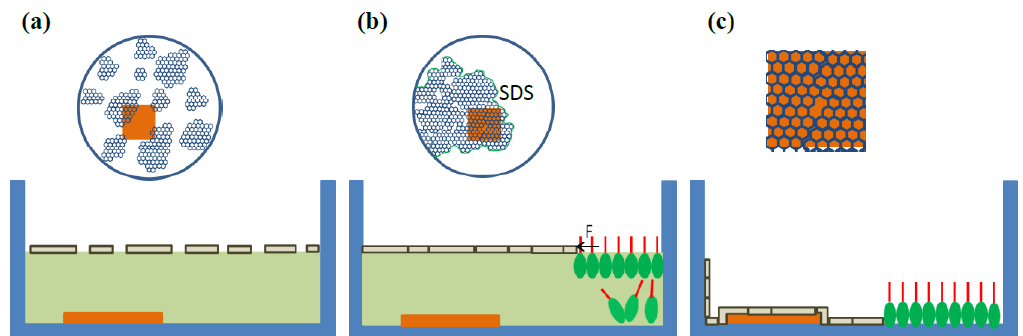
Figure 1. Sketch of the double self-assembly (DSA) process for the graphene coating in the top view (upper images) and cross sectional view (lower images): ( a ) Dispersion of the graphene flakes on the water surface forming a loose monolayer of graphene flakes (MGFs); ( b ) compression of the MGFs by sodium dodecyl sulfate (SDS) molecules to form a densely packed MGFs with the excess SDS molecules staying immersed in water; ( c ) pumping out of water (or raising the sample out of the water) so that the dense MGFs settle down on the substrate.